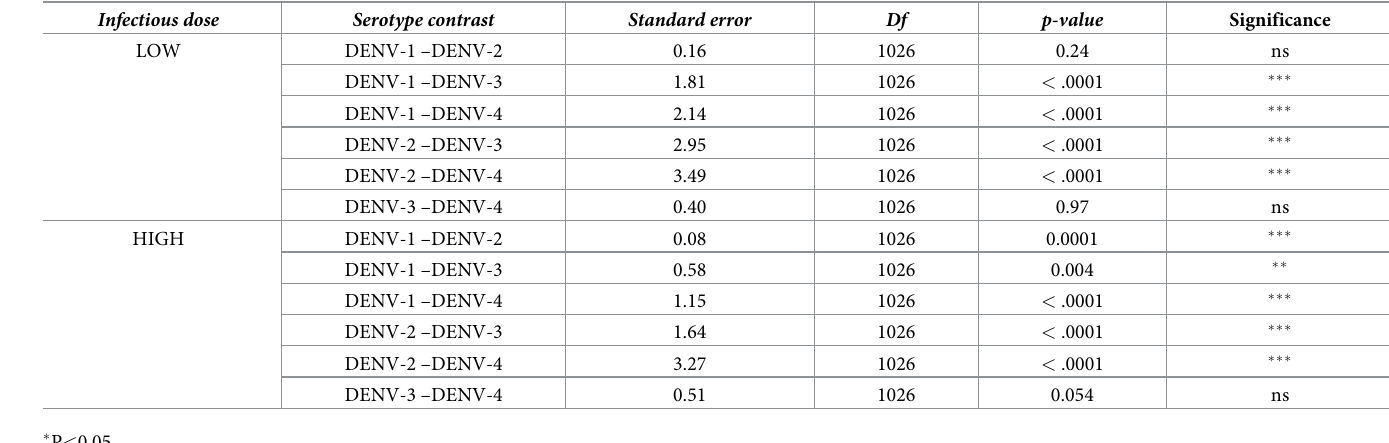
Table 5. Serotype contrasts for growth rate in